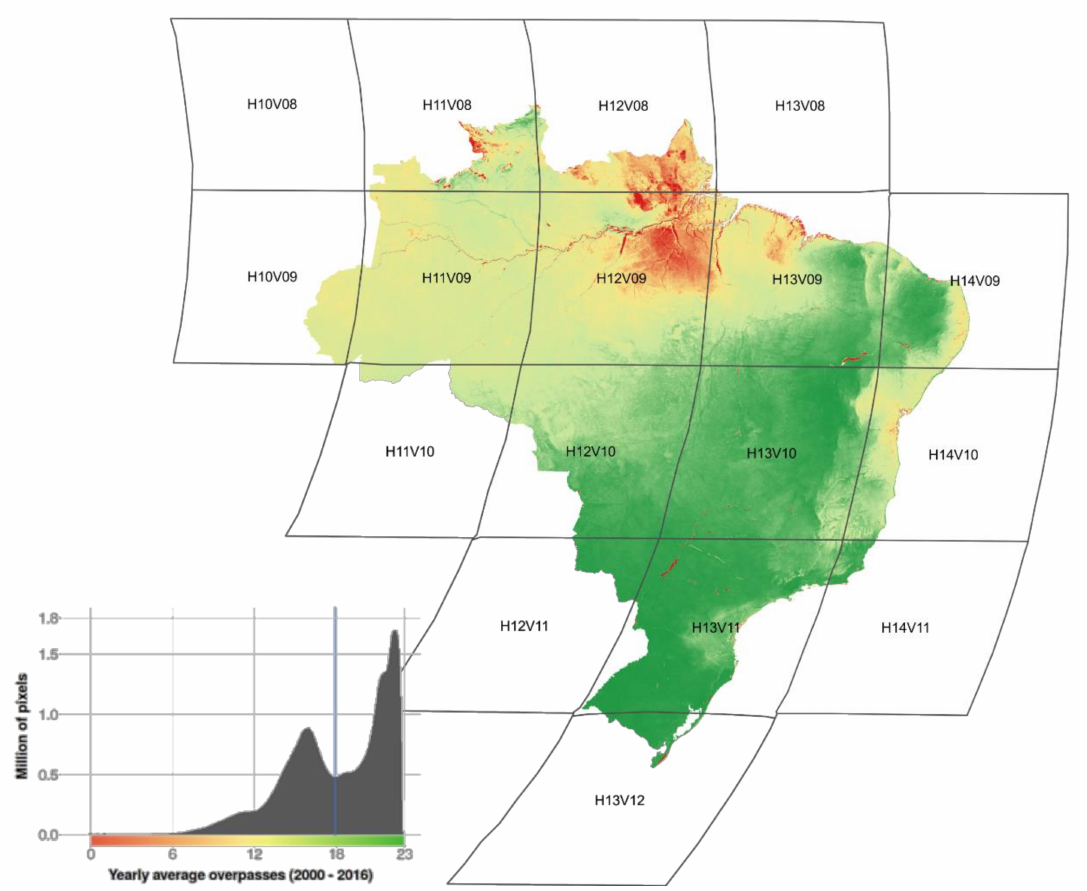
Figure 7. Annual average of MODIS observations considering only the best quality pixels (i.e., values 0 and 1, according to the pixel reliability image) in the period of 2000 and 2016. The blue line represents the average value of MODIS observations for the entire Brazilian territory during the same